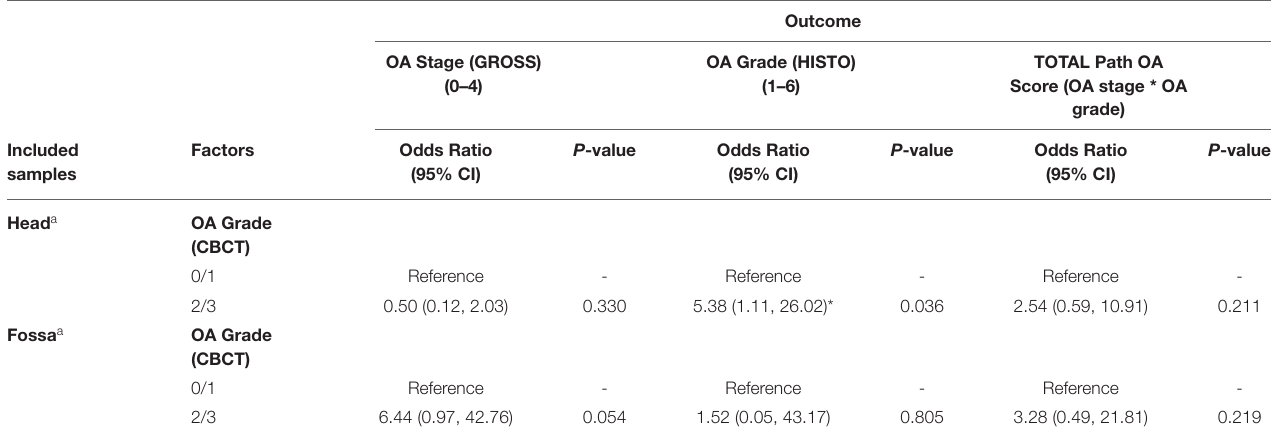
TABLE 5 | Summary of association between OA Grade (CBCT) and other grades (side is